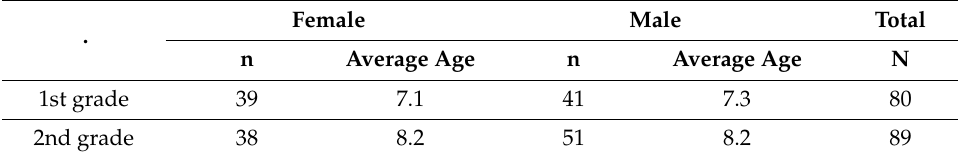
Table 1. Sample distribution according to degree and